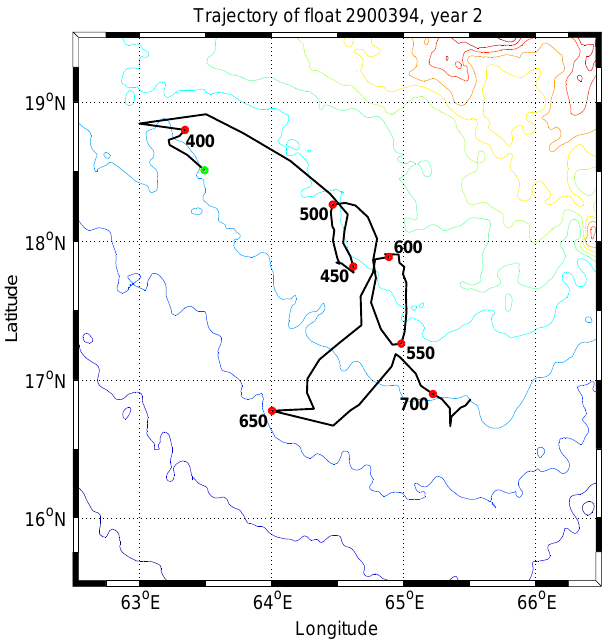
Fig. 24. Trajectory of float 2900394, for year 2, superimposed on Figure 24: Trajectory of float 2900394, for year 2, superimposed on bathymetry. A bathymetry. A green dot indicates the initial position of the float; green dot indicates the initial position of the float; red dots mark the position of the red dots mark the position of the float every 50 float every 50 days.